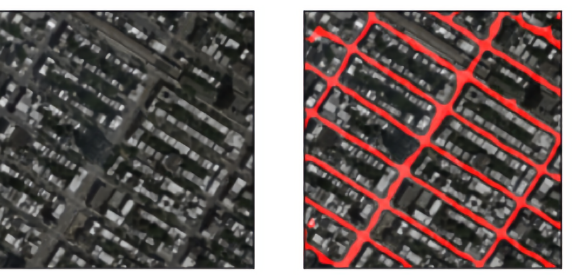
Figure 12. A sample prediction on Pix2Pix using the trained model, which is post-processed and overlaid on the original image.